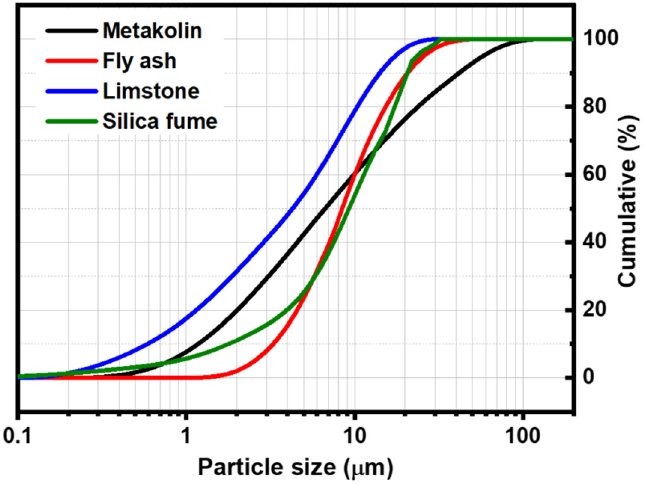
Figure 3. Particle size distribution of input material powders.